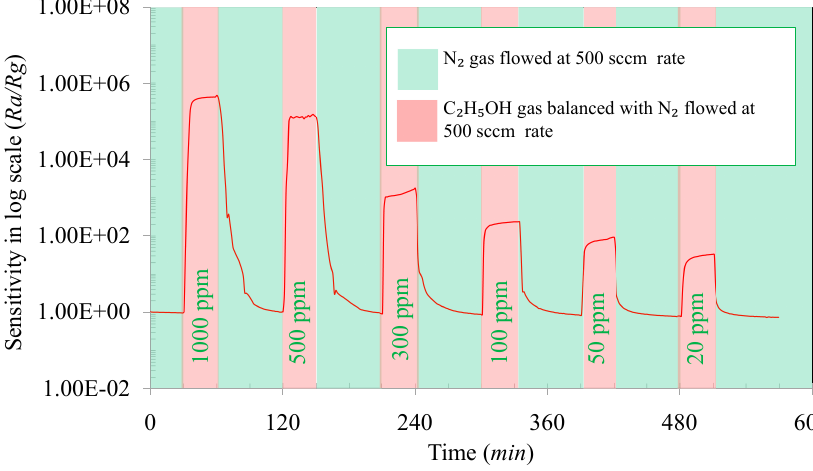
Figure 7. Sensitivity of the sensor towards C (20 ppm–1000 ppm) at 600